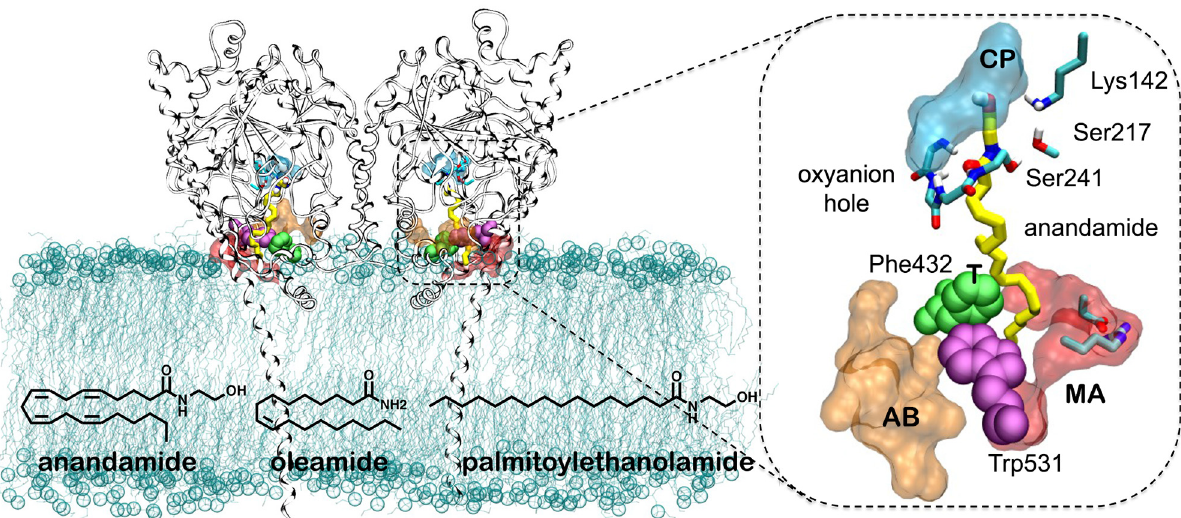
Fig 1. Overview of the FAAH protein (pdb 1MT5) [1] in complex with anandamide, embedded in a 1-palmitoyl-2-oleoyl-phosphatidylethanolamine (POPE) lipid bilayer. The enzyme is a homodimer, which is shown in gray ribbons. The lipids of the membrane are represented in cyan lines with the phosphate atoms highlighted as spheres. A close view of the binding site is shown on the right. The substrate anandamide is shown in yellow sticks, while the catalytic triad (Ser241-Ser217-Lys142) and the oxyanion hole (Ser241-Gly239-Gly240-Ser241) residues are represented in cyan sticks. The so called “ membrane access ” (MA — red) and the “ acyl chain binding ” (AB — orange) channels, as well as the “ cytosolic port ” (CP — cyan) are depicted in molecular surface representation. The interface region between the MA and AB channels is indicated as transition region (T). The Asp403 and Arg486 residues of the MA channel, which favor the substrates entrance within FAAH active site, are also shown as sticks. Key residues — Phe432 (green) and Trp531 (magenta) — are shown in space-filling representation. For clarity, explicit water molecules included in the simulations are omitted. The chemical structure of the FAAH substrates here considered — anandamide, oleamide, and palmitoylethanolamide (PEA) — is also shown.